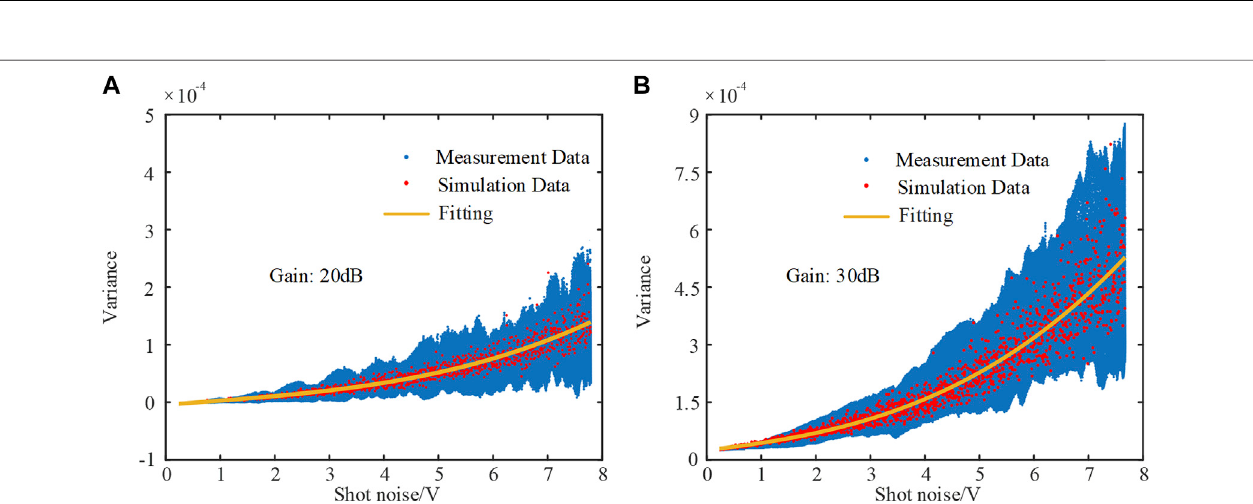
FIGURE 5 | Calibration results of Poisson shot noise of detector 2 at (A) 20 dB and (B) 30 dB at 632.8 nm.